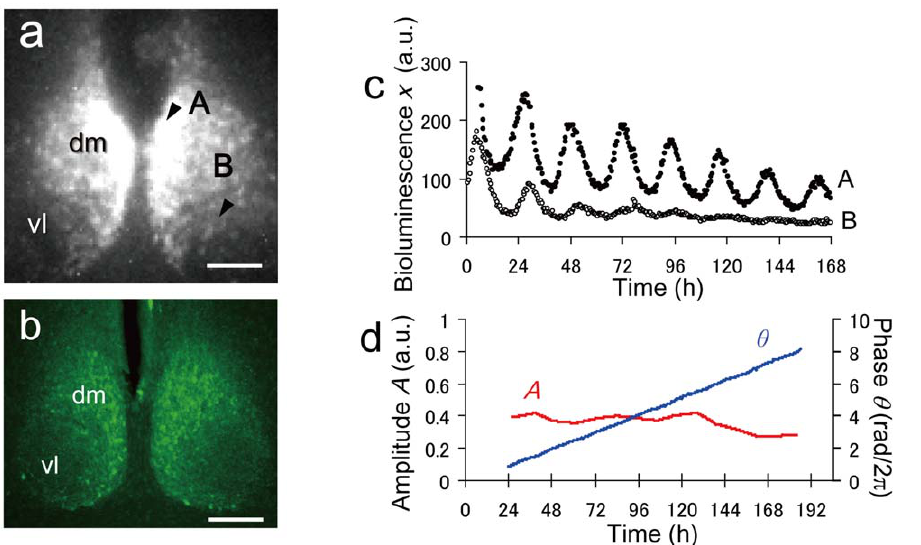
Figure 1. Oscillatory bioluminescence of a cultured rat SCN slice from a Per2::Luc transgenic rat. (a) A bioluminescence image of the cultured SCN slice. (b) Image of an immunostained SCN section. AVP (arginine vasopressin)-positive neurons predominantly distributed in the dmSCN are shown. The scale bar indicates 200 m m length. (c) Time series of bioluminescence x(t) at points (A) and (B) indicated in Fig. 1a. (d) Amplitude A(t) (red line) and phase h (t) at point (A) computed, respectively, by Eq. [1,2]. dm: dorsomedial SCN; vl: ventrolateral SCN.